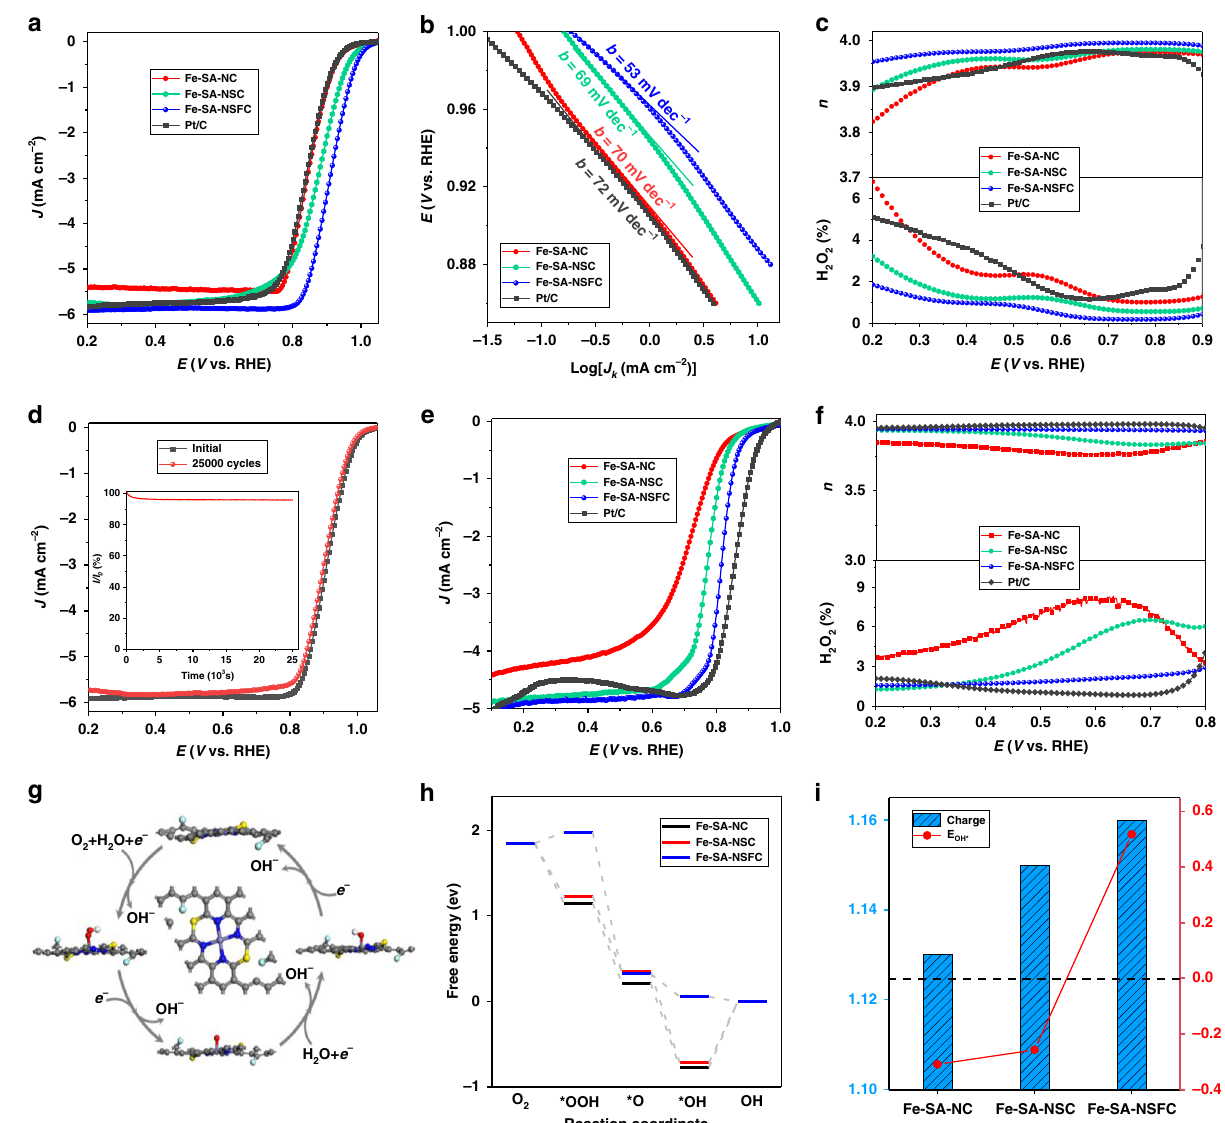
Fig. 4 Electrocatalytic ORR performance. a ORR polarization curves, b Tafel plots, and c electron-transfer number ( n ) (top) and H 2 O 2 yield (bottom) for the Fe-SA-NC, Fe-SA-NSC, Fe-SA-NSFC, and Pt/C in 0.1 M KOH solution. d ORR polarization curves of the Fe-SA-NSFC before and after 25000 CV cycles; the inset of d shows the i – t curve at 0.9 V and 1600 r.p.m. for 25,000s. e ORR polarization curves and f electron-transfer number ( n ) (top) and H 2 O 2 yield (bottom) for the Fe-SA-NC, Fe-SA-NSC, Fe-SA-NSFC, and Pt/C in 0.1 M HClO 4 solution with rotation speed of 900 r.p.m. g Proposed 4 e − reduction mechanism in alkaline solution for the ORR on Fe-SA-NSFC; the inset shows the structure of the Fe-SA-NSFC. h Free energy diagram for the Fe-SA-NC, Fe- SA-NSC, and Fe-SA-NSFC ( U = 0 V vs. RHE, pH 13). i OH* binding energies and Mulliken charges of the FeN 4 active centres in the Fe-SA-NC, Fe-SA-NSC, and